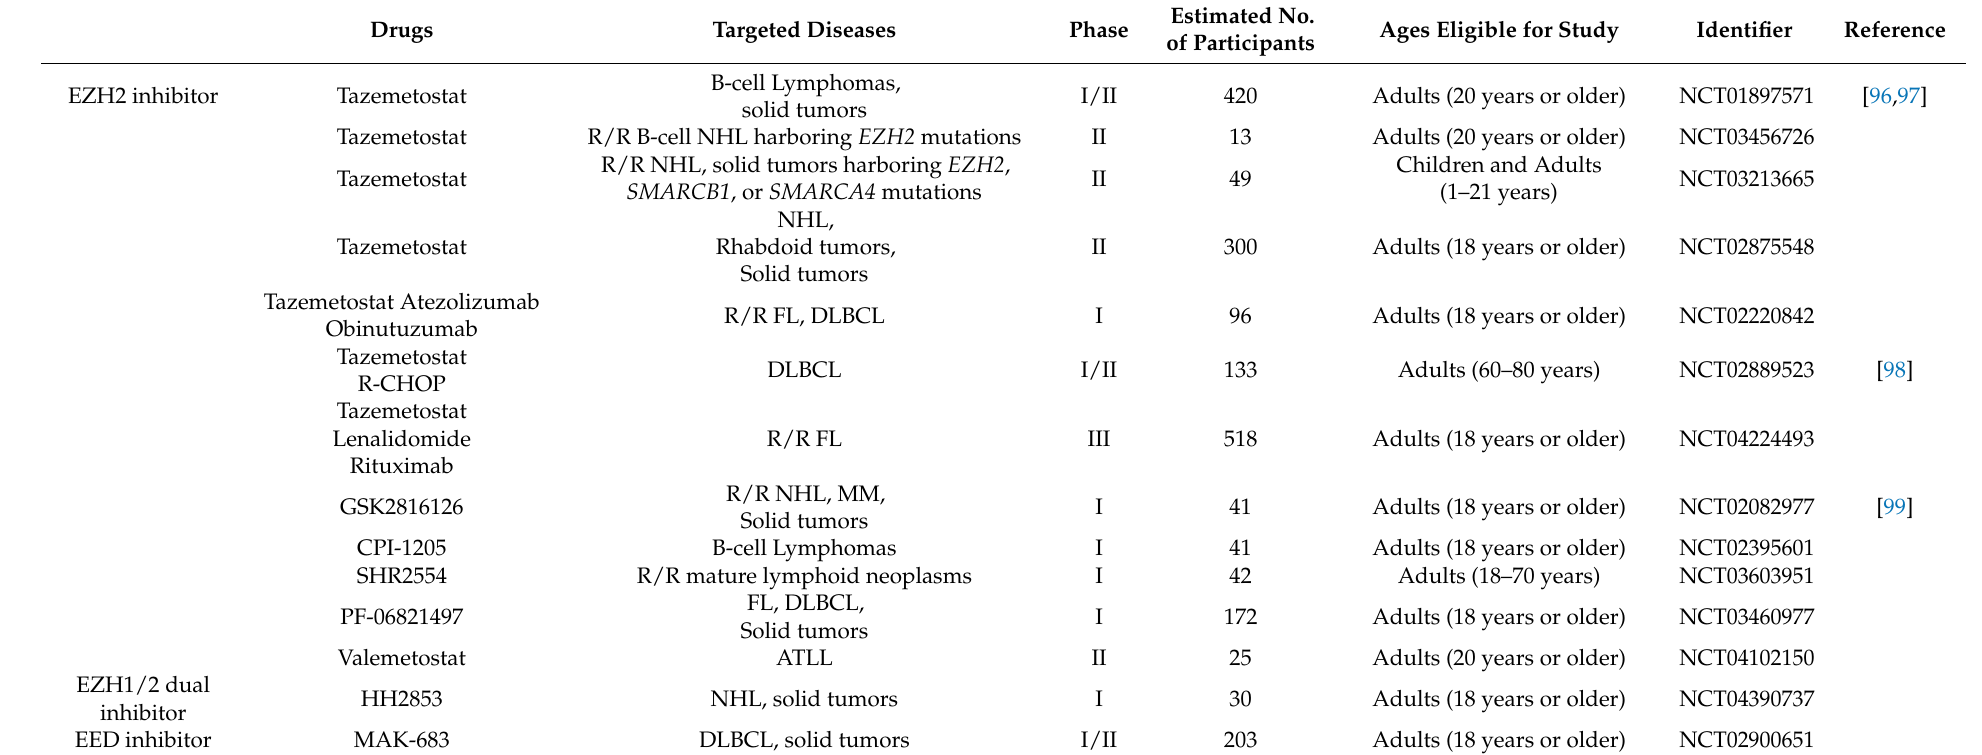
Table 2. Clinical trials of PRC2 inhibitors for hematologic